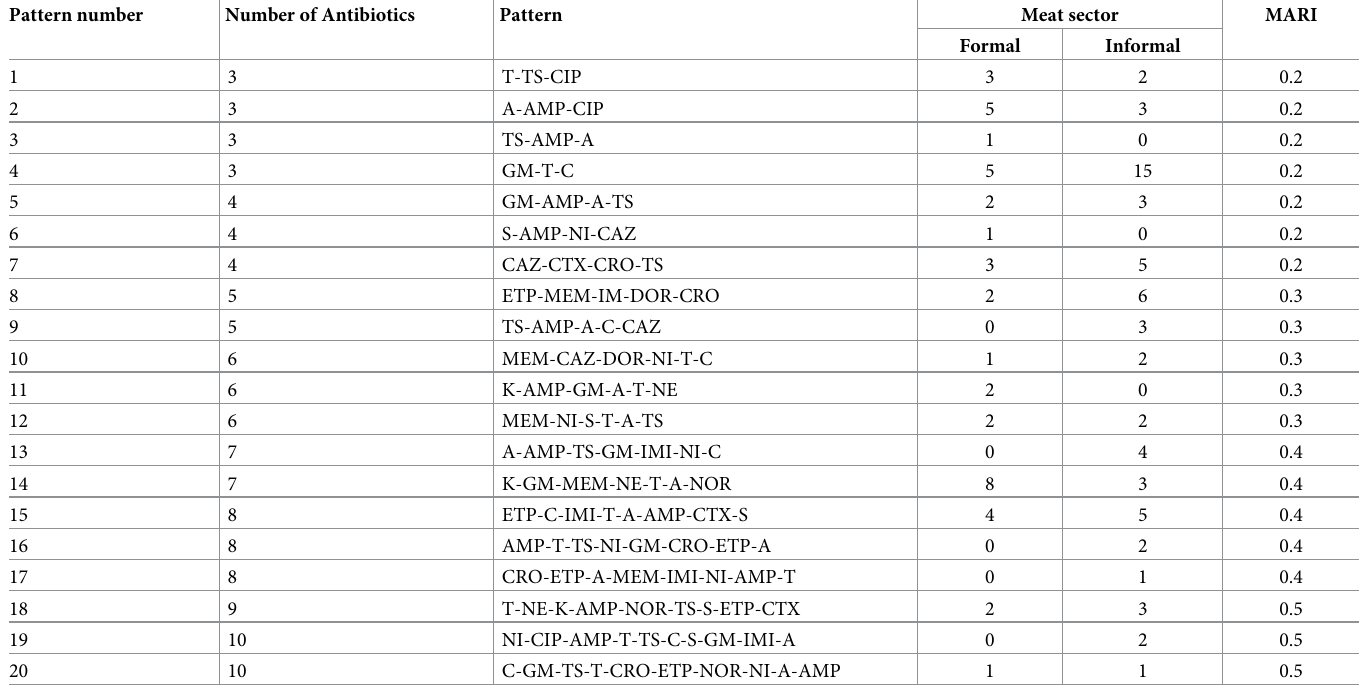
Table 3. Multiple Antibiotic-Resistant Phenotypes (MARPs) pattern of E . coli isolates from the formal and informal meat sector.